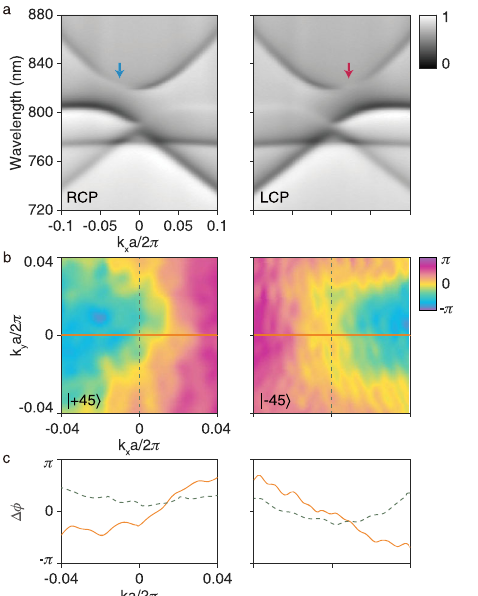
Fig. 3 Experimentally measured photonic bands and PhC-induced phase distributions. a The measured angle-resolved transmittance spectra of the PhC slab with (left panel) right-handed circularly polarized (RCP) and (right panel) left-handed circularly polarized (LCP) incident beam. Photonic bands of the PhC slab appear as dips in the spectra. The mode with LCP (RCP) polarization eigenstate, marked with blue (red) arrow, will not respond to the RCP (LCP) excitation and turn out to be a diminished point among the band signals. b Measured phase distributions induced by the cross- polarized conversion process of the PhC slab at 816 nm. The incident and the analyzed polarizations in the left (right) panel are þ 45 j i ( (cid:2) 45 j i ) and (cid:2) 45 h j ( þ 45 h j ) respectively. c The phase distributions along the lines marked in b . Solid (dashed) curves in the left and right panels show the phase distributions along the solid (dashed) lines in the left and right panels of b correspondingly.